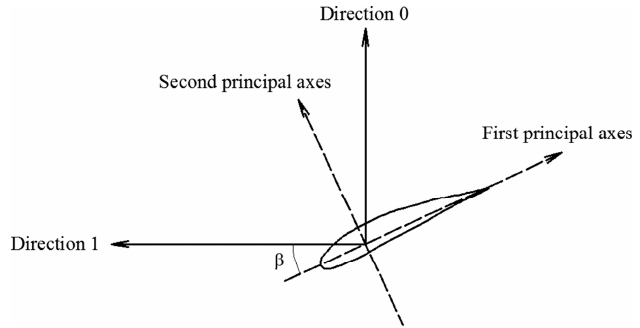
Figure 3. The diagrammatic sketch of the forces on the cantilever beam.